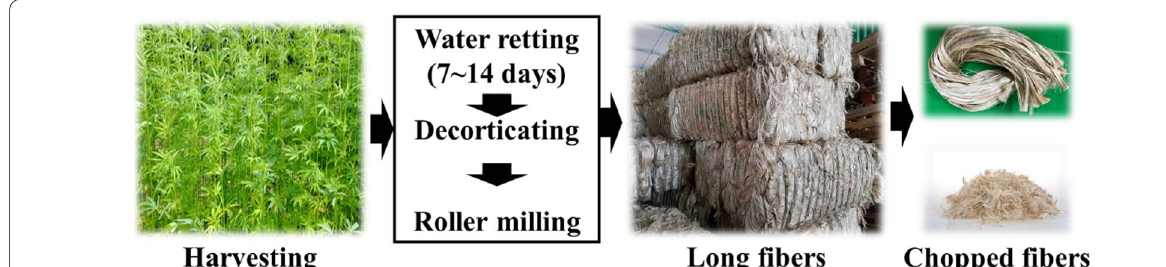
Fig. 1 Manufacturing process of plant-based natural